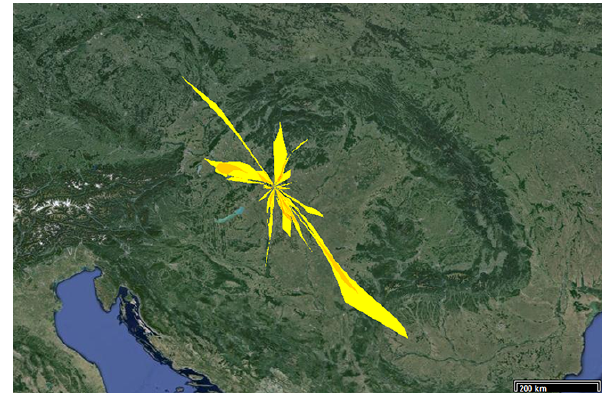
Figure 4. Arrival fields of nucleating air masses in the Carpathian Basin for the city centre of Budapest. The overlapping sections were indicated in stronger shaded colours (from yellow to